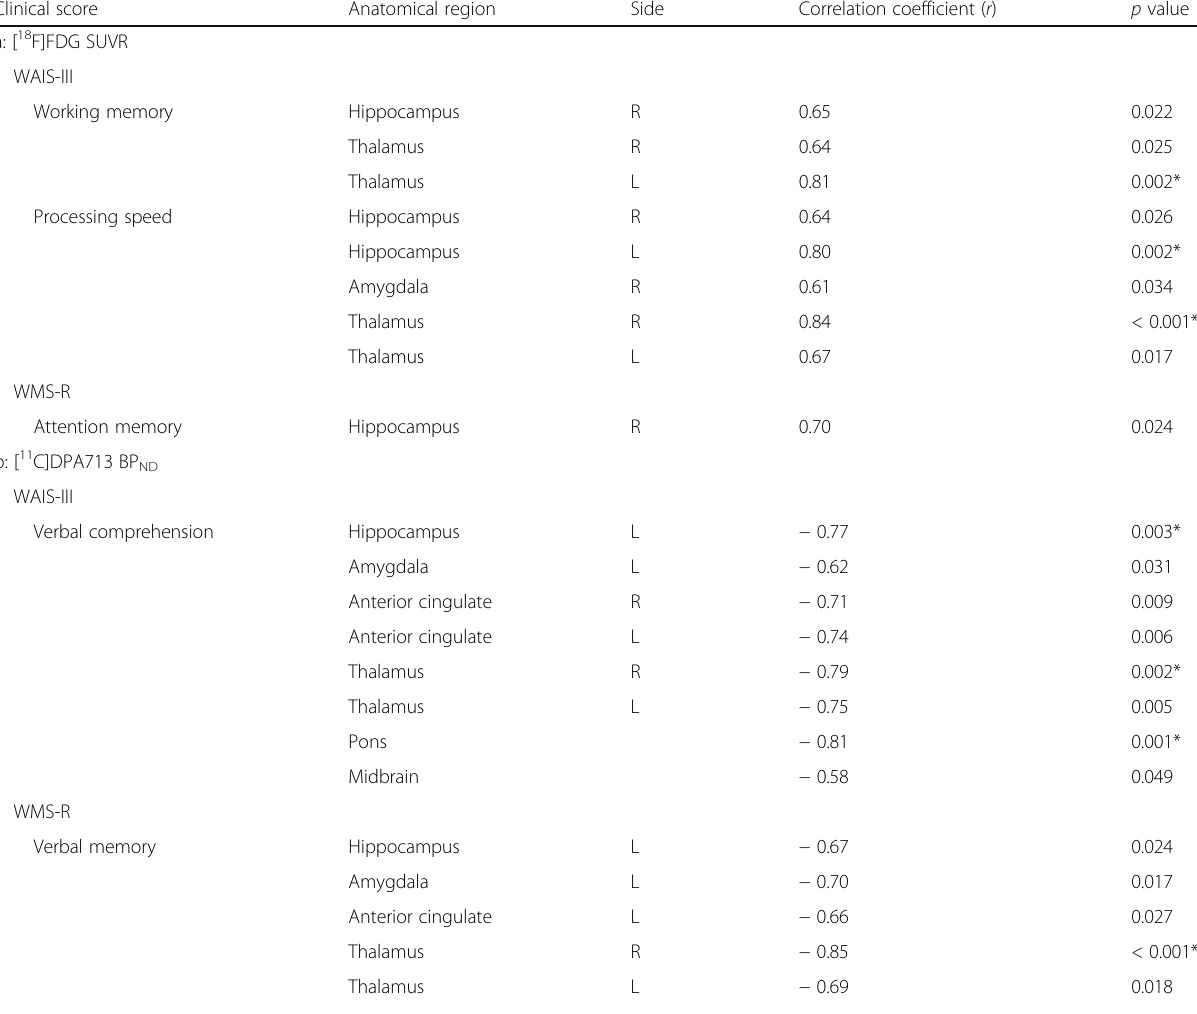
Table 3 Correlation between [ 18 F]FDG SUVR or [ 11 C]DPA713 BP ND values and clinical scores Clinical